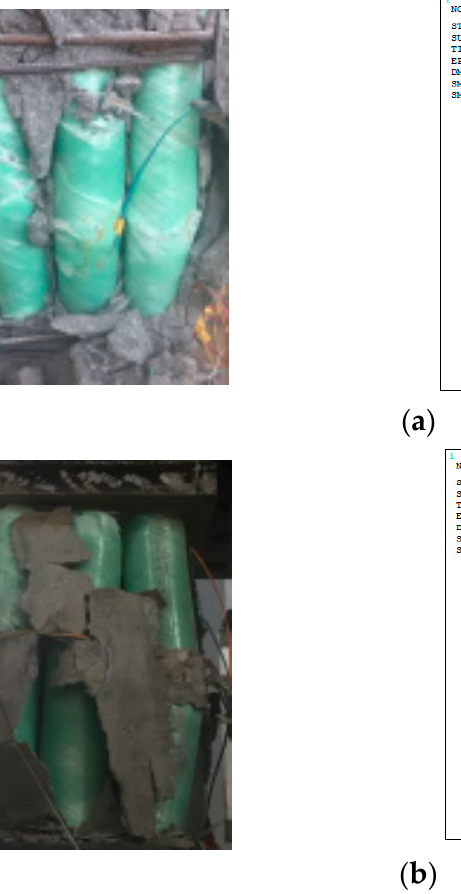
Sensors 2019 , 19 , x FOR PEER REVIEW